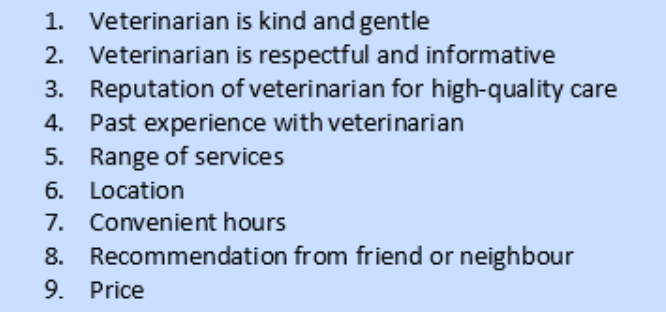
Figure 4. Client selection factors when choosing a veterinarian (Brown & Silverman, 1999) In addition to price, location and product range, service industries have a common set of choice criteria that can be applied to them (Hill & Hill,